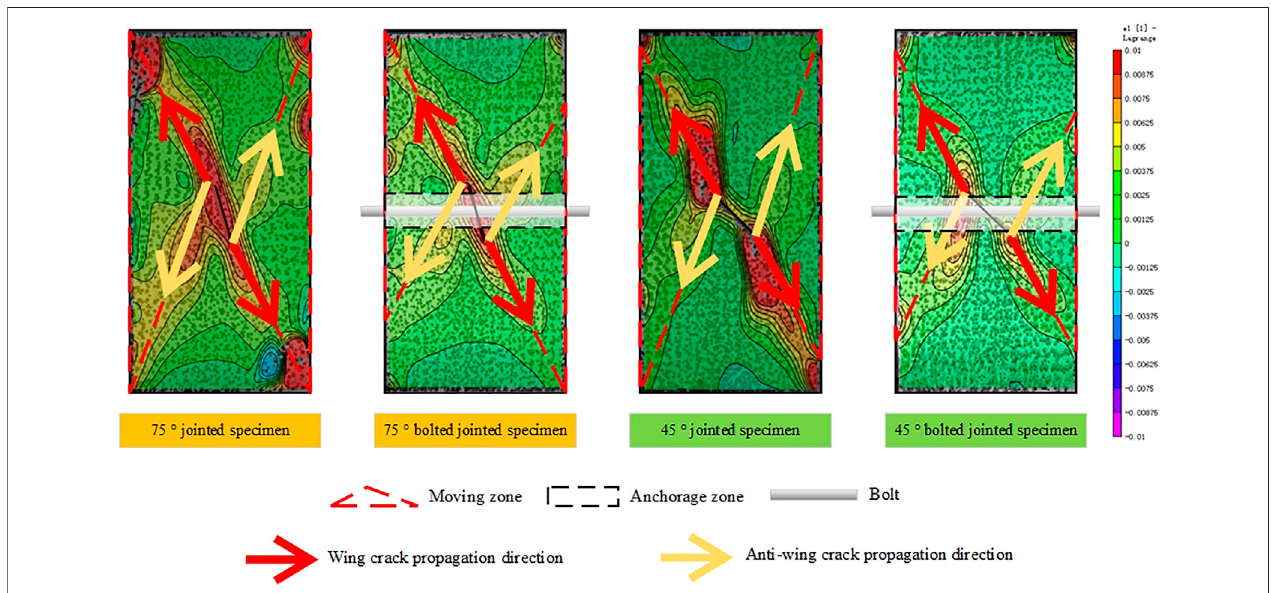
FIGURE 4 | Maximum principle strain distribution of jointed and bolted jointed